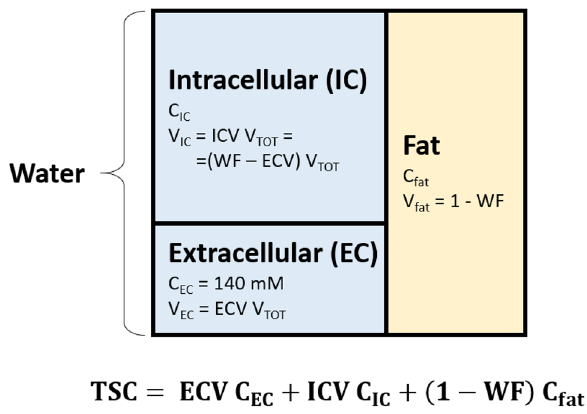
Figure 1. Three compartment model of an imaging voxel. Each voxel is constituted by water (blue) and fat (yellow) in different proportions. Within the water portion we identify an intracellular (IC) and an extracellular (EC) compartments. In our study we assume the extracellular sodium concentration ( C EC ) to be fixed to 140 mM, which simplifies the calculation of intracellular sodium concentration ( C IC ). TSC, total sodium concentration; C fat , fat sodium concentration; ECV, extracellular volume fraction; ICV, intracellular volume fraction; WF, water fraction; V TOT , total voxel